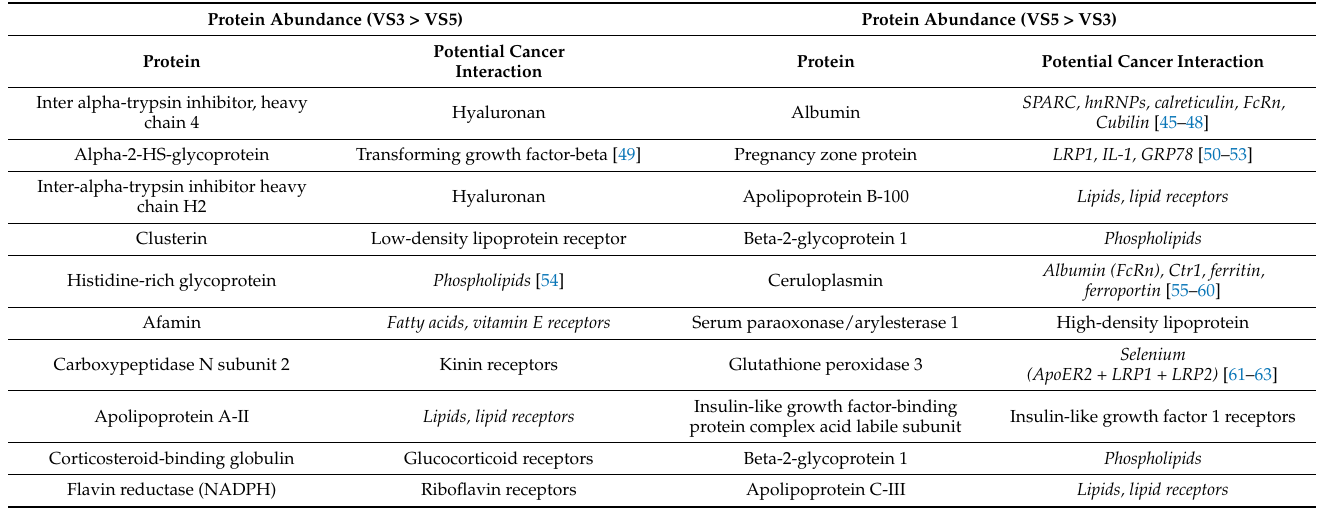
Table 3. List of top 10 proteins absorbed by HBPE-NPs treated with VS3 or VS5 with potential cancer interaction (multi-ligand receptors in italics ) based on data from known ligands, MDA-MB-231 cells (https://www.uniprot.org/, https://www.kobic.kr/GEMICCL/), or reviewing the literature. Abundance was determined by multiplying the individual protein spectral count by (the average total spectral count among samples divided by the total spectral count for an individual